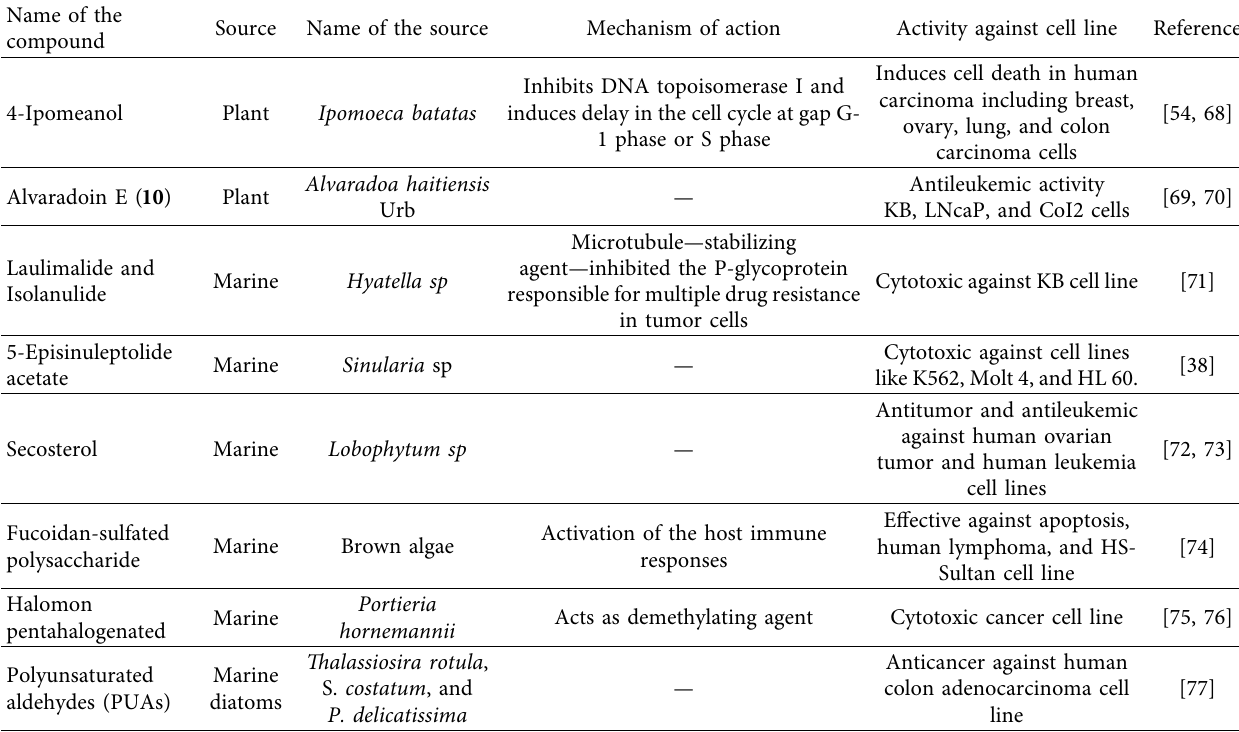
Table 2. All the chemical compounds isolated from bio- logical sources that are under clinical trials are presented in Table 2.